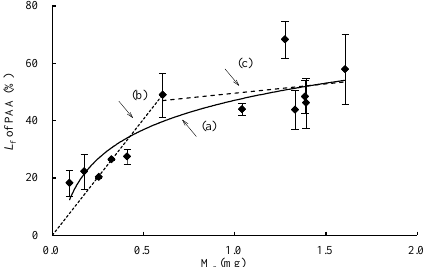
Figure 2. The trend line of fractional loss ( L f ) of PAA against PM 2 . 5 mass ( M a ) (60%RH). Error bars are 1 standard deviation. Solid line (a), the logarithmic trend line of L f against M a among all mass values; dotted line (b), the linear correlation of L f against M a in the low mass region; dotted line (c), the nearly constant L f against M a in the high mass region.